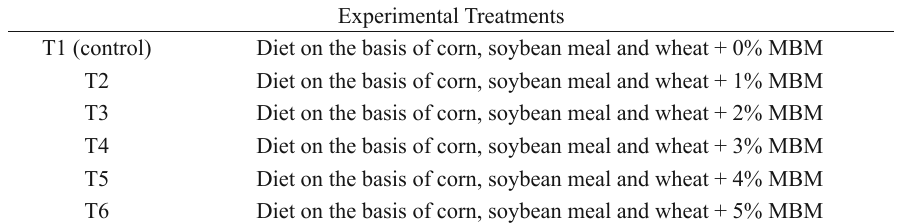
Distribution of the experimental diets, using six levels of addition of bovine meat and bone meal (MBM) in the diets in place of soybean meal. Experimental Treatments